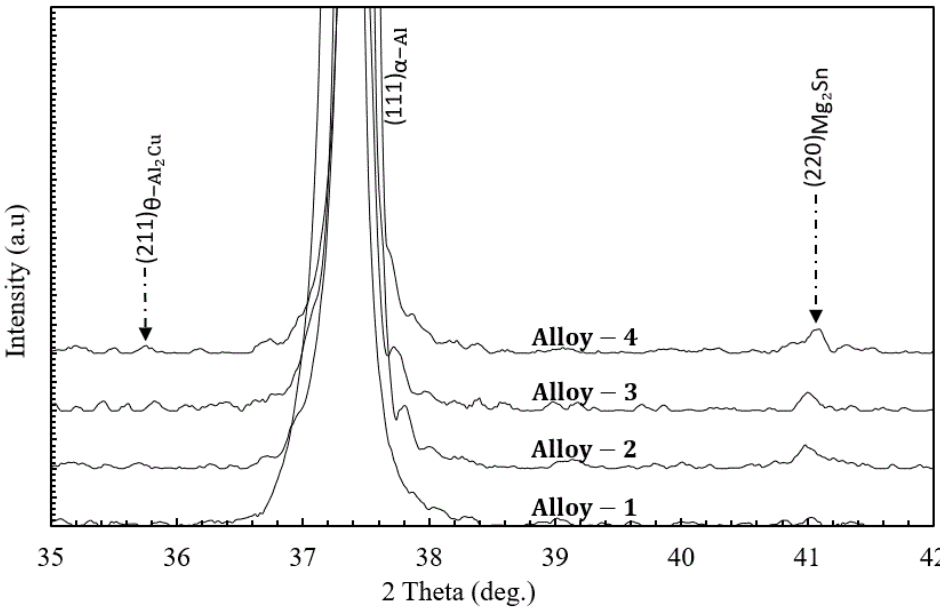
Figure 5. X-ray diffraction (XRD) patterns of the of the peak aged treated Alloy-1, Alloy-2, Alloy-3 and Alloy-4 specimens.